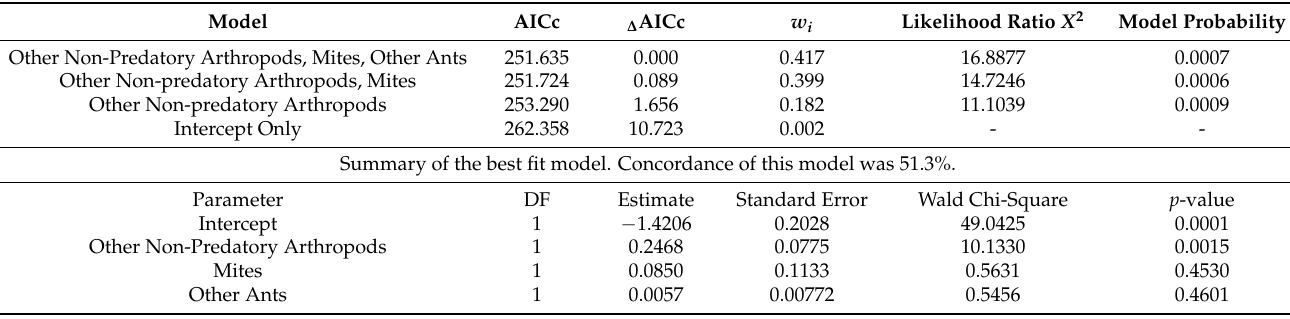
Table 2. Summary of stepwise logistic regression analysis of survival of monarch eggs or larvae based on arthropod groups (see Table 1) found on host plants. A stepwise selection procedure was used to generate these models with a significance level for entry into the model set at 0.30 and significance level for removal from the model set at 0.35. Models are sorted in order of ascending AICc. Best model is based on minimum corrected AIC Score (AICc), w i is the Akaike weight of each